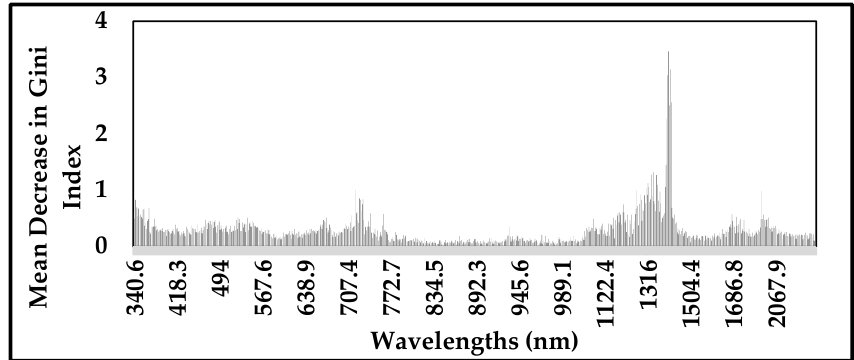
Figure 4. The importance of wavelengths as measured by the traditional RF using the mean decrease in the Gini index . The most important variables are those with the highest mean index.